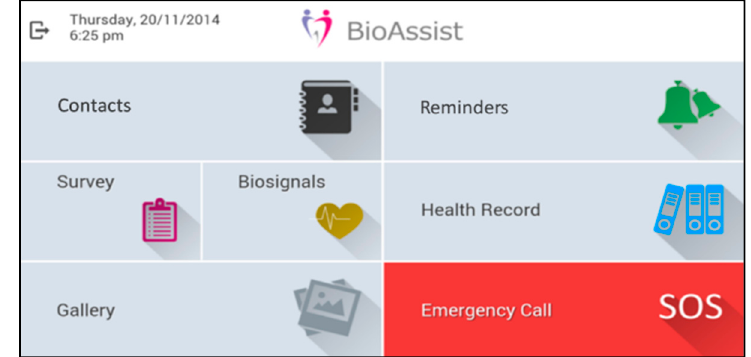
Figure 2. “HeartAround” Mobile Application—Home Screen.